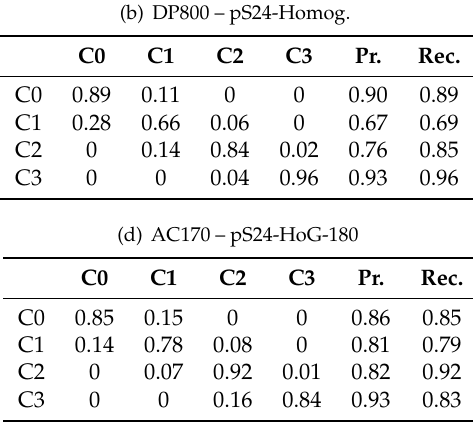
Table 3. Overall confusion matrices of the best performing feature for each material.